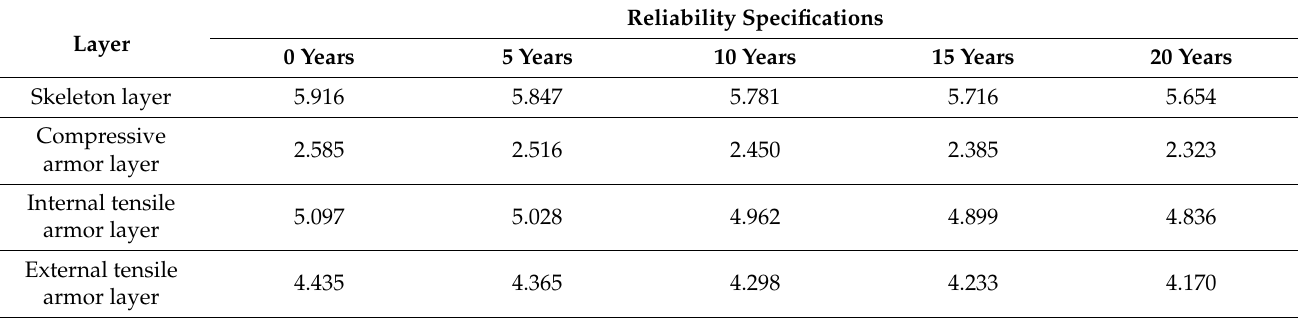
Table 6. Reliability indicators for different years.